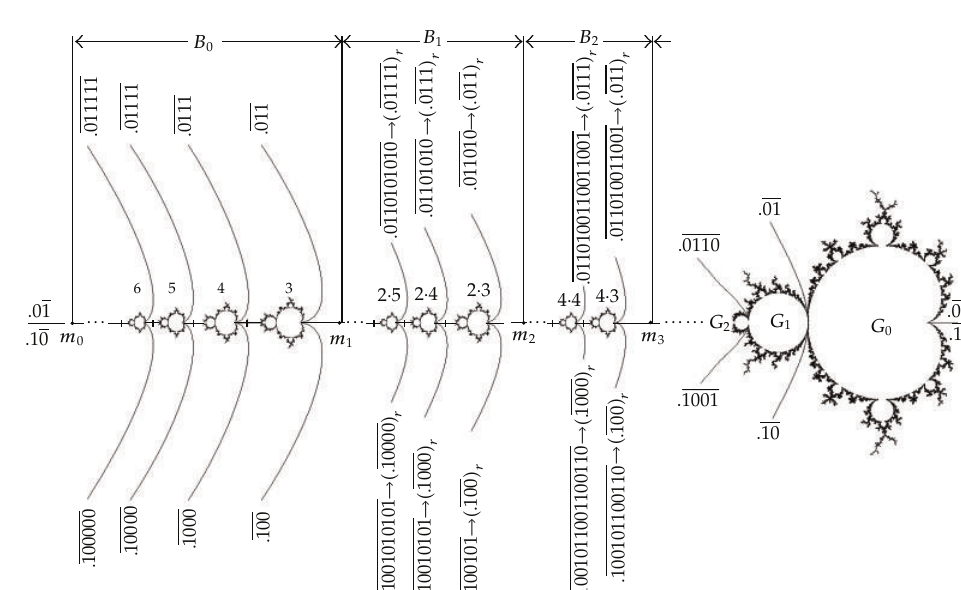
Figure 3: Mandelbrot set and a sketch of the antenna showing the first three chaotic bands B 0 , B 1 , and B 2 separated by the merging points m i . In each chaotic band, the reduced EAs of the first LLAHCs are